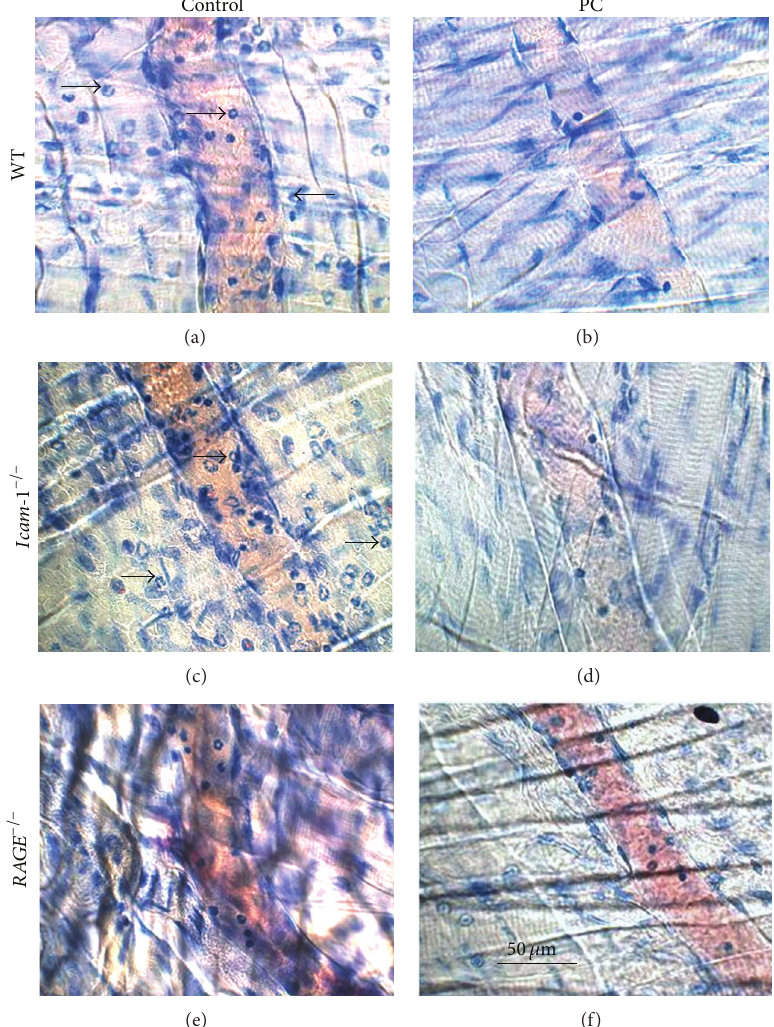
Figure3:LeukocytetransmigrationinPC-treatedwild-type, RAGE −/− , and Icam-1 −/− miceafterTNF 𝛼 stimulation.Leukocytetransmigration is illustrated by representative micrographs of Giemsa-stained cremaster muscle whole mounts after 5 min fMLP superfusion (1 𝜇 M) in the TNF 𝛼 -model in WT, Icam-1 −/− , and RAGE −/− mice with and without PC treatment (100U/kg, 3 hours) (a–f). Reference bar is shown in (c). Arrows point to extravasated